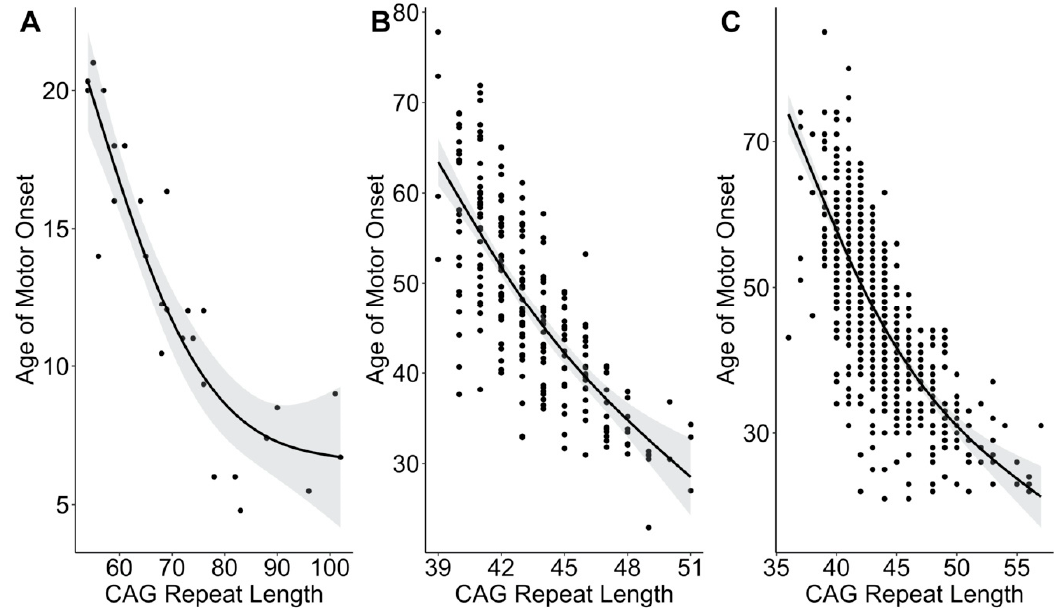
Figure 2. Cytosine–adenine–guanine (CAG) repeat length significantly predicts the age of motor onset in ( a ) patients with juvenile-onset Huntington’s disease (JOHD) from the Kids-JOHD study, ( b ) patients with adult-onset Huntington’s Disease (AOHD) from the Predict-HD study, and ( c ) patients with AOHD from the Enroll-HD study. Black lines show the predicted regression lines, and the gray ribbons display the 95% confidence intervals.